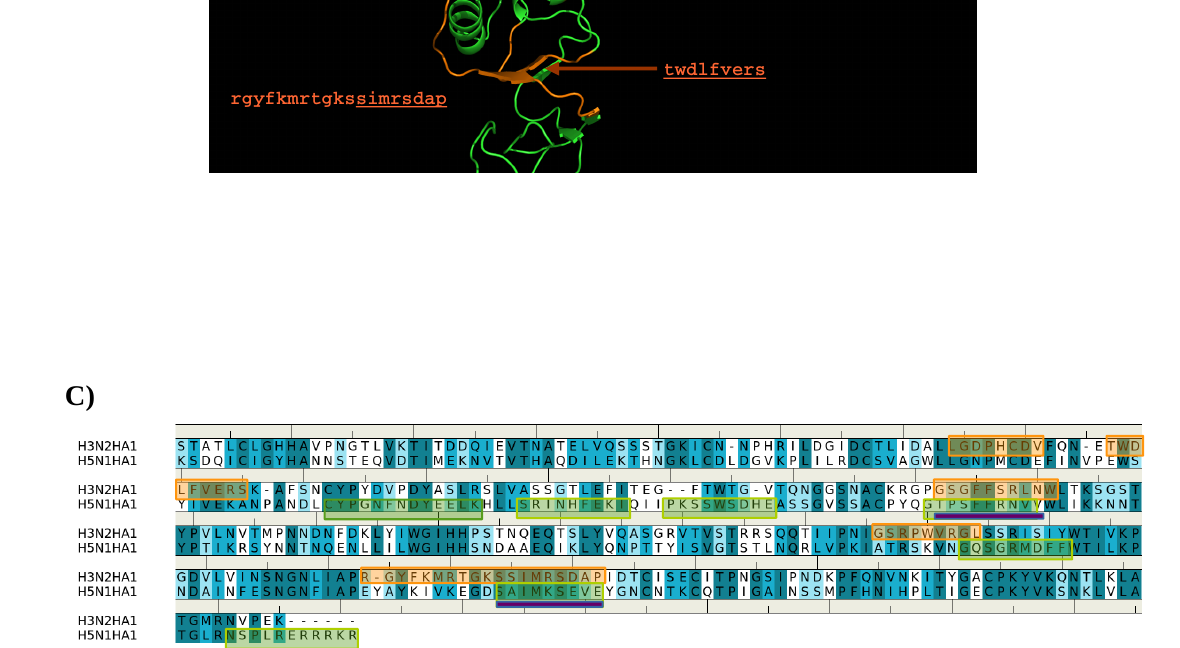
Figure 3. ( A ) the predicted epitopes of H3N2 HA1 that binds to antibody HC19. The epitopes are highlighted in lower case and colored orange in the protein sequence. ( B ) Backbone representation of the antigen H3N2 HA1 showing the predicted epitopes in orange and the antibody in surface. ( C ) Sequence alignment of HA1 protein of influenza viruses H3N2 and H5N1. The boxes highlight the epitopes predicted for H3N2 ( orange ) and H5N1 ( green ). The overlay regions between two subtypes are underlined in purple. Figures were prepared using PyMOL